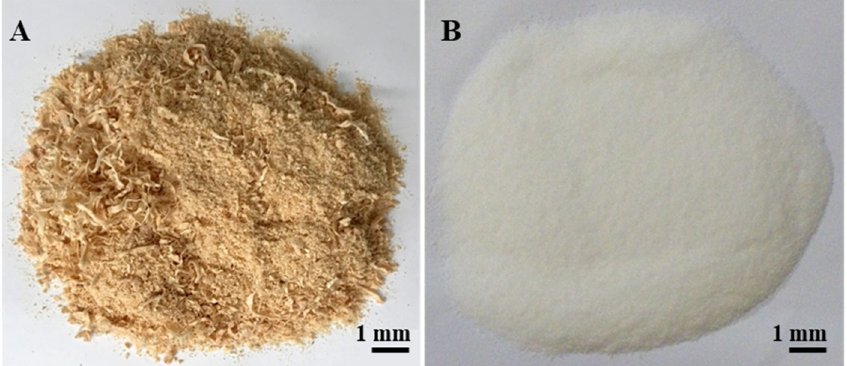
Figure 1. Raw materials: ( A ) Pine wood sawdust and ( B )